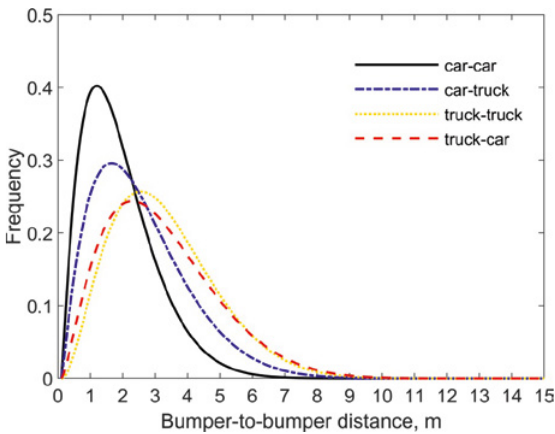
Figure 10. Beta distribution of bumper-to-bumper vehicle gaps (Bailey,